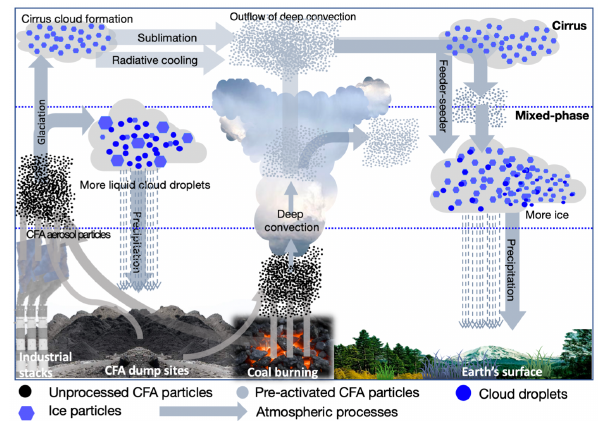
Figure 9. A schematic showing possible pathways and interactions of CFA particles in the atmosphere. The arrows represent possible pathways and atmospheric processes that may be relevant for the PCF mechanism in mixed-phase and cirrus cloud regimes. After the emission of the particles to the atmosphere, they can directly trigger heterogeneous ice formation in both cirrus and mixed-phase clouds (left-hand side). The processing of these particles through lower temperatures can promote ice formation by the pore conden- sation and freezing mechanism (middle) and generally influence the hydrological